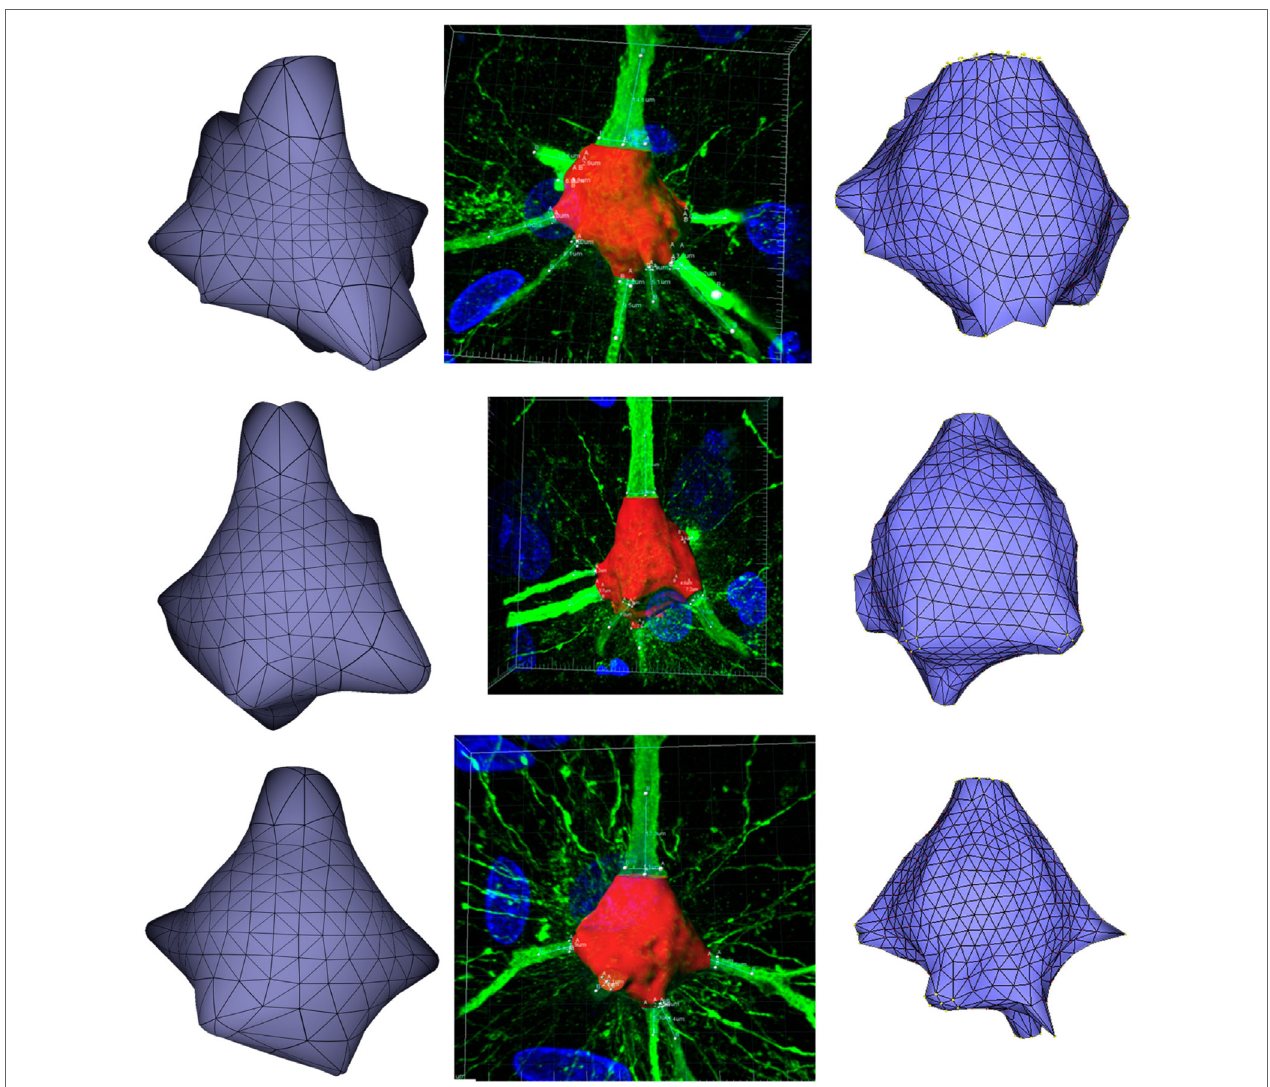
FIGURe 11 | Comparison between the real somata (middle images), the meshes generated with Neuronize (right images), and the meshes generated with our proposal (left images), for three different somata A, B, and